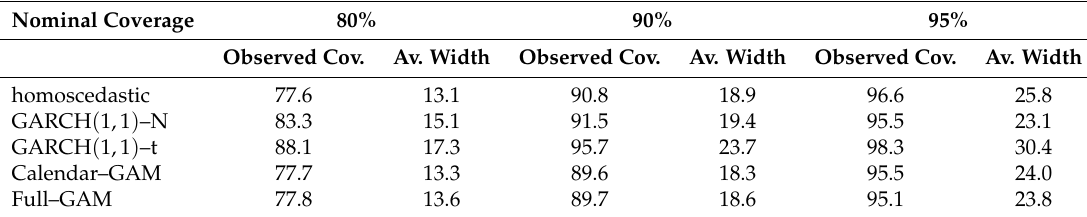
Table 6. Electricity prices for the northern zone. Out-of-sample predictive results for the year 2019. For all models the MAE is equal to 4.36 and the MAPE is equal to 10.1%. Moreover, “observed cov.”